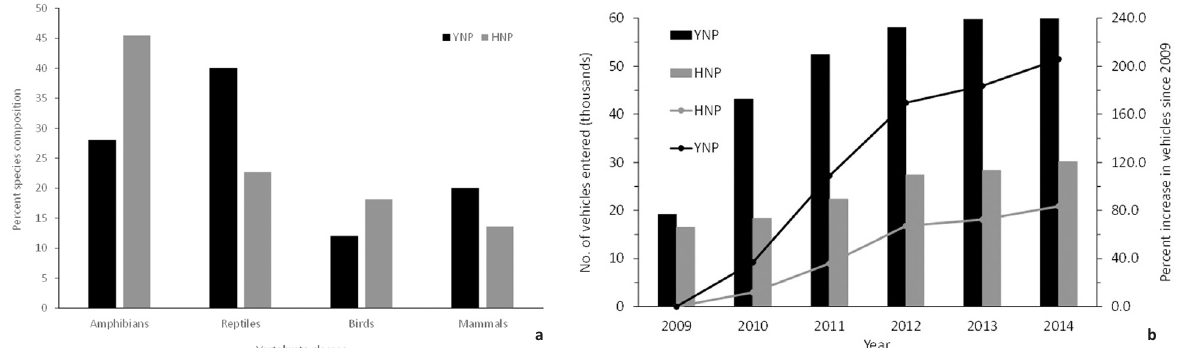
a Figure 2. (a) Percent species composition of road mortality in both YNP (Yala National Park, black) and HNP (Horton Plains National Park, grey). Species composition = (Number of roadkilled species per each vertebrate class at each national park ÷ total number of roadkilled species of all classes found at each national park) × 100%; (b) Entrance of tourist vehicles into the Yala National Park (YNP) and Horton Plains National Park (HNP) from 2009 to 2014. The bars indicate total number of vehicles entered each park in each year. The lines indicate the percent increase in number of vehicles in each year at each park as a fraction of number of vehicles entered in 2009. Percent increase in vehicles since 2009 = (Number of vehicles entered each park each year ÷ Number of vehicles entered each park in 2009) × 100%.